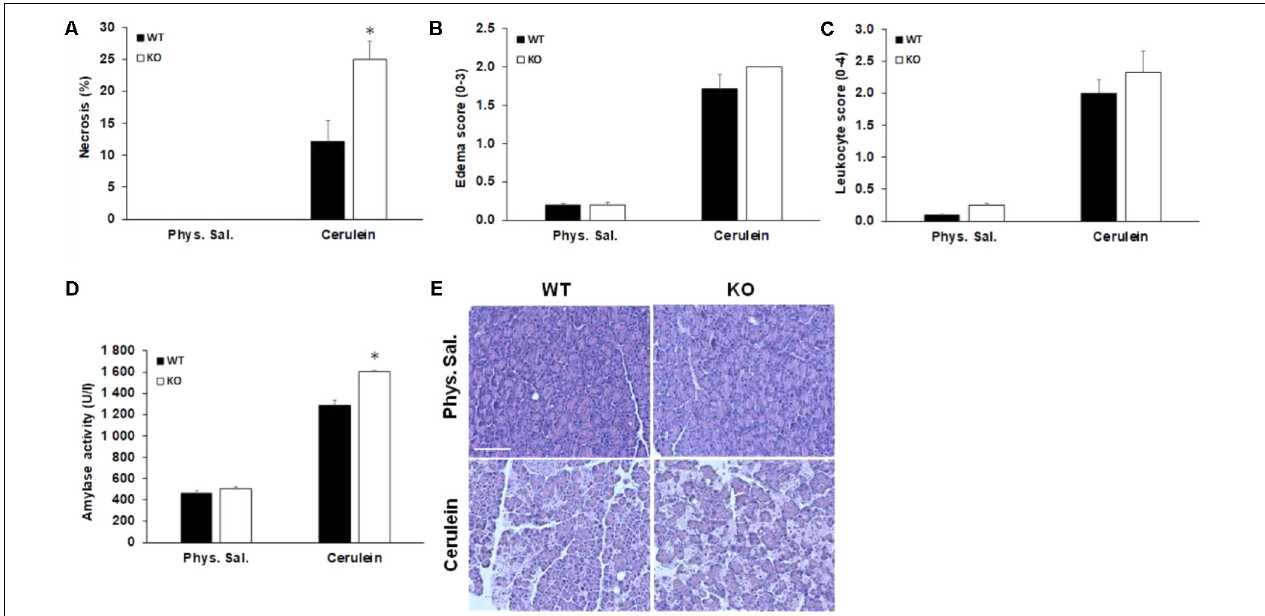
FIGURE 5 | Characterization of acute pancreatitis in AQP1 knock out mice. (A) Pancreatic cell necrosis, (B) edema, (C) leukocyte infiltration, and (D) serum amylase activity (U/l) were measured in wild-type (WT) and AQP1 knock out (KO) mice after induction of pancreatitis. Control animals received the same amount of saline. Data are presented as means ± SEM. ∗ p ≤ 0.05 vs. WT. (E) Representative histological images show pancreatic sections from control (physiological saline) and cerulein-treated animals. Phys sal., physiological saline. Scale bar represents 50 µ